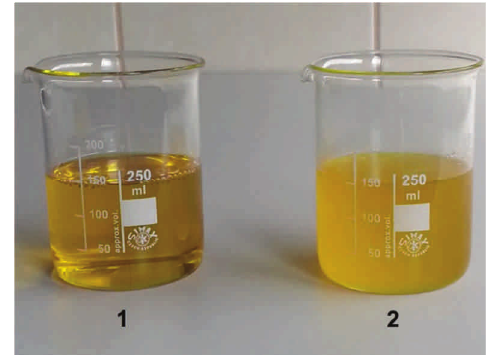
Fig. 3. Diesel fuel blend with 15% ethanol content: 1 – with dodecanol, 2 – without dodecanol